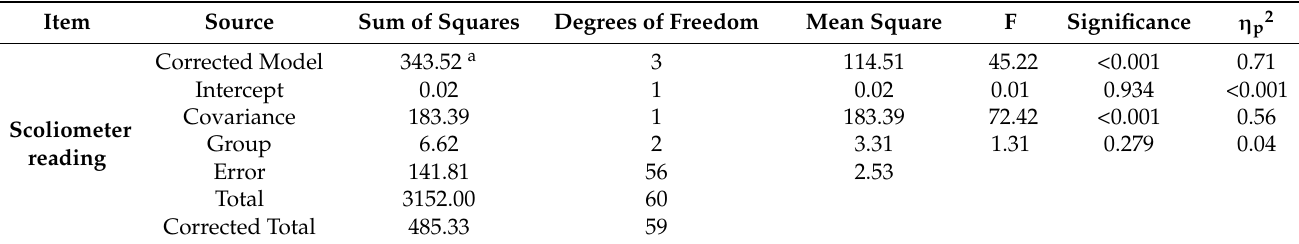
Table 6. Analysis of covariance results for scoliometer readings.